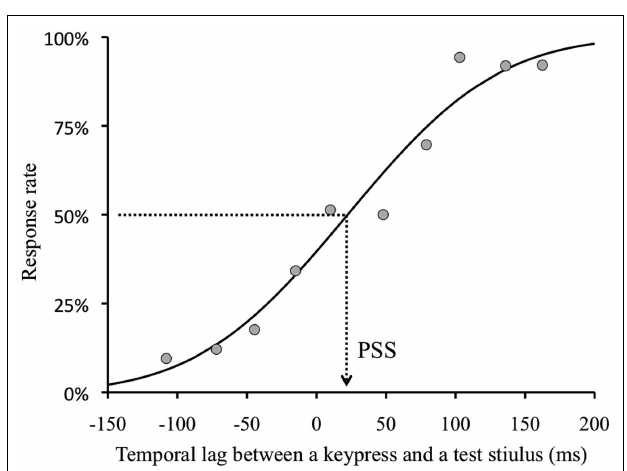
FIGURE 3 | Sample psychometric function. Example of an observer H. I. for 0ms lag and opposite visual field condition.The dots indicate the proportion of “A visual flash appeared after a keypress.” response in each divided group. Negative value of temporal lag indicates that a test stimulus was presented before a keypress.